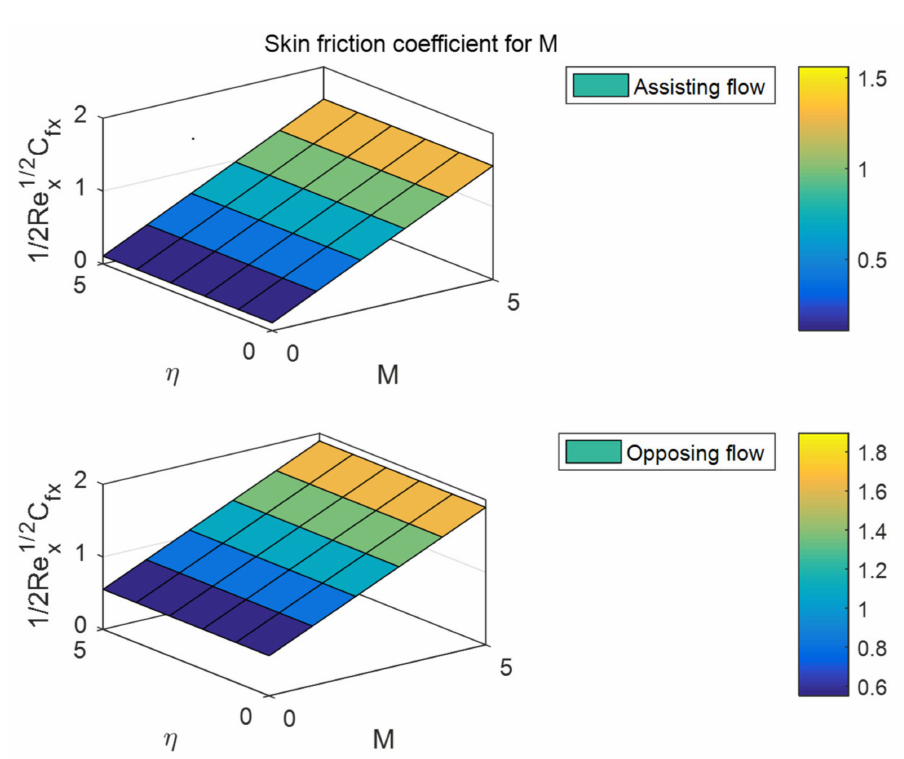
Figure 25. Surface plots of the f (cid:48)(cid:48) ( 0 ) for dissimilar values of M